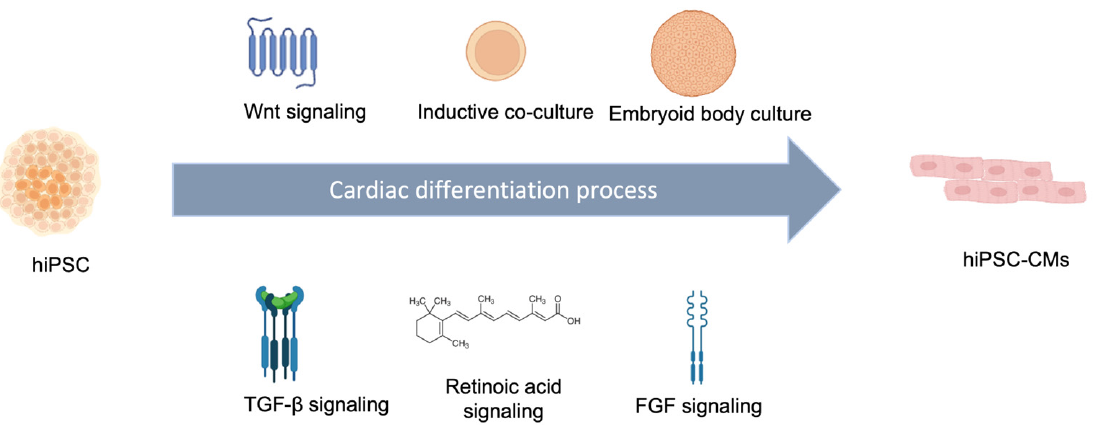
Figure 2. Current development of cardiac differentiation process by hiPSC for cardiomyocyte gen- eration based on Wnt, TGF- β , FGF, and retinoic acid signaling pathway. Culture methods such as inductive co-culture with embryoid body culture.